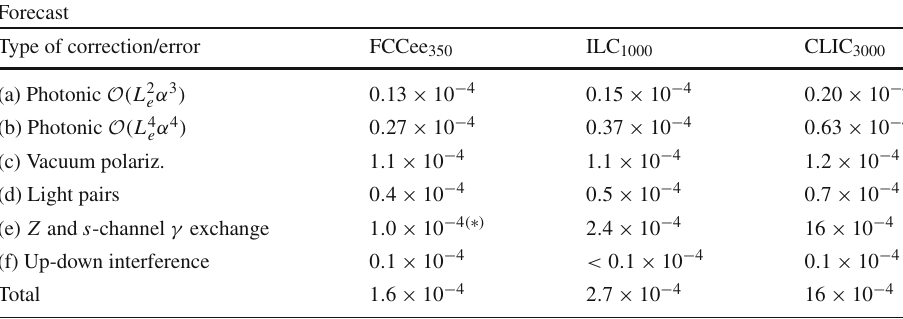
Table 4 Forecast of the total (physical) theoretical uncertainty for the FCCee 350 , ILC 1000 and CLIC luminosity calorimetric detectors with angular acceptances as defined in the text. Number ( (cid:12) ) is likely overestimated. The total error is summed in quadrature. A technical error is not